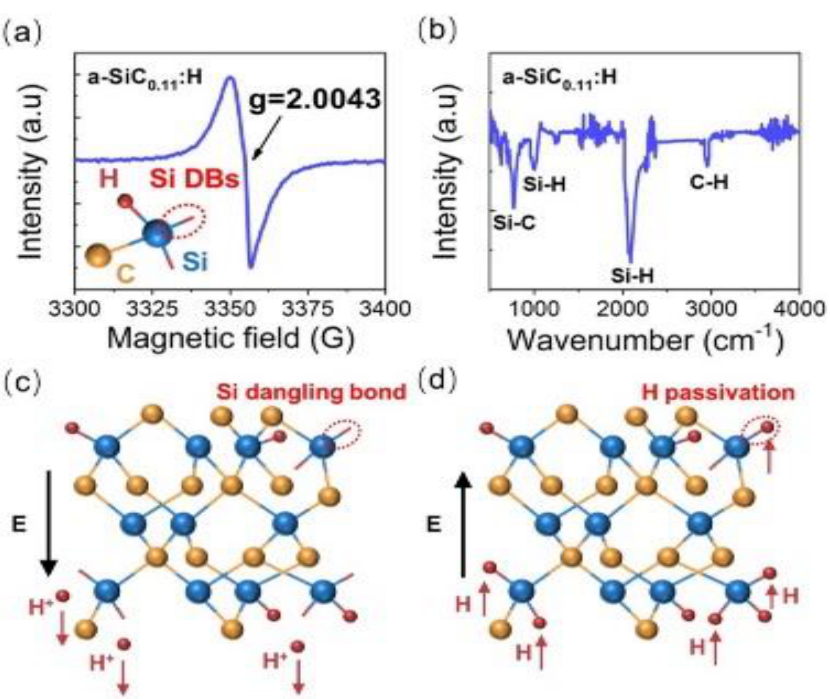
Figure 3. ( a , b ) ESR and FTIR spectra of as-deposited a − SiC 0.11 H films; ( c ) Under a positive bias, Si dangling bonds were formed, due to the broken Si – H bonds; ( d ) Under a negative bias, Si dangling bonds were passivated by H + .